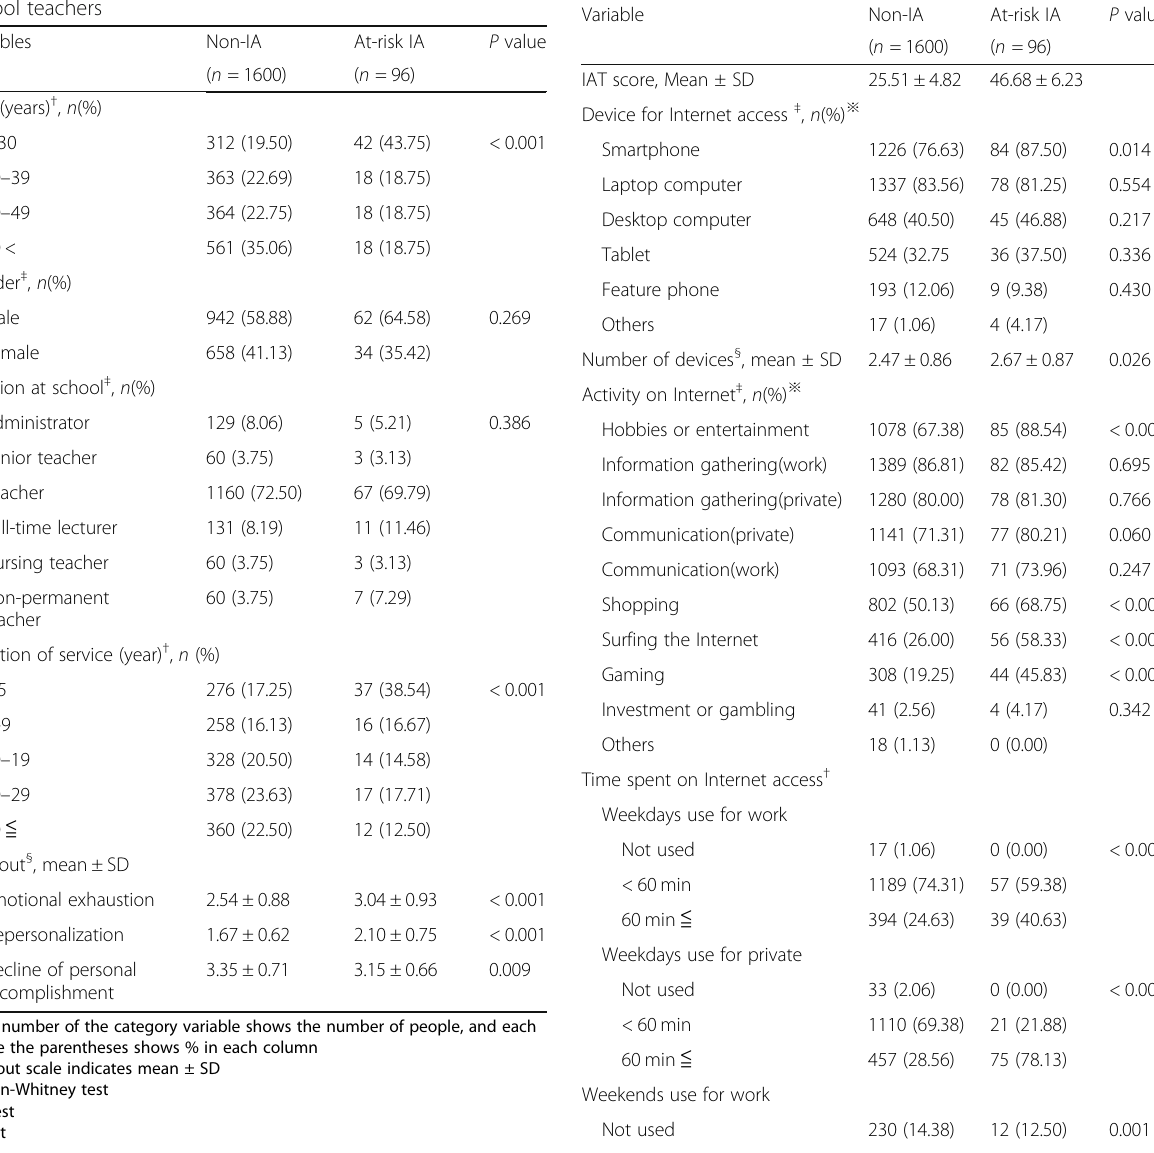
Table 1 Characteristics of respondents or burnout score with at-risk Internet addiction(IA) and non-IA among junior high school teachers